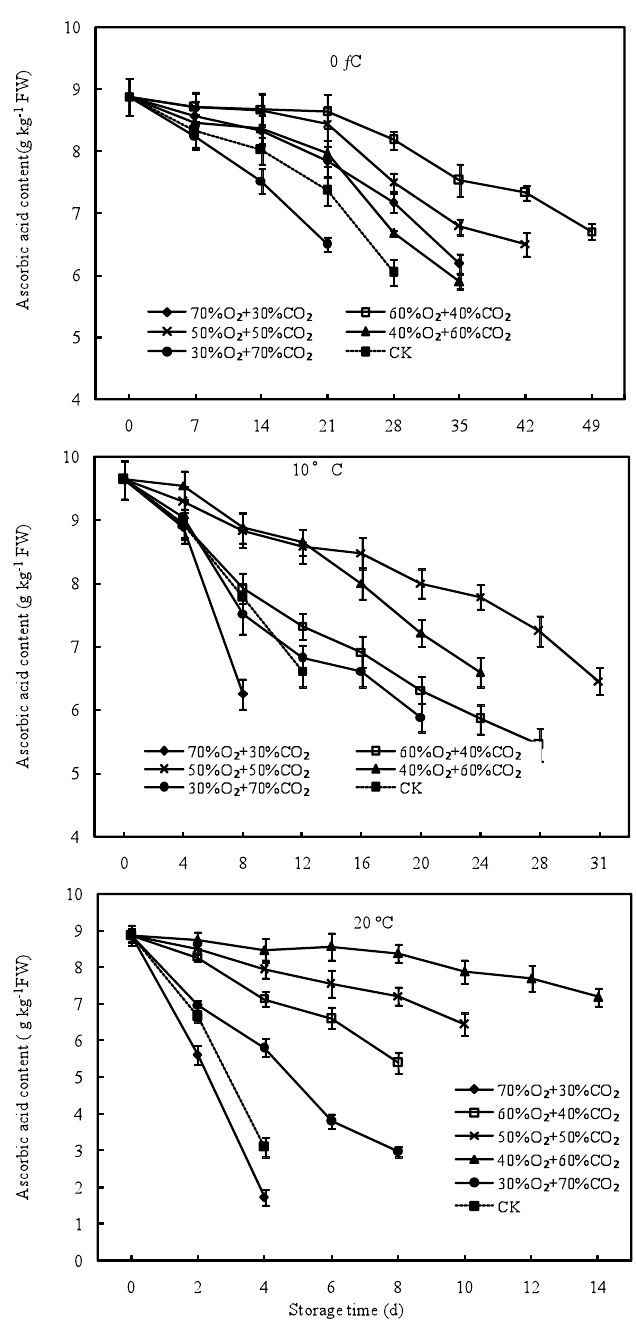
Fig. 7: Ascorbic acid contents of broccoli heads treated with varying O 2 / CO 2 levels at different temperature. Vertical bars indicate the stan-levels at different temperature. Vertical bars indicate the stan- at different temperature. Vertical bars indicate the stan-at different temperature. Vertical bars indicate the stan- different temperature. Vertical bars indicate the stan- dard deviations for each treatment (n=5). Air treatment was used the